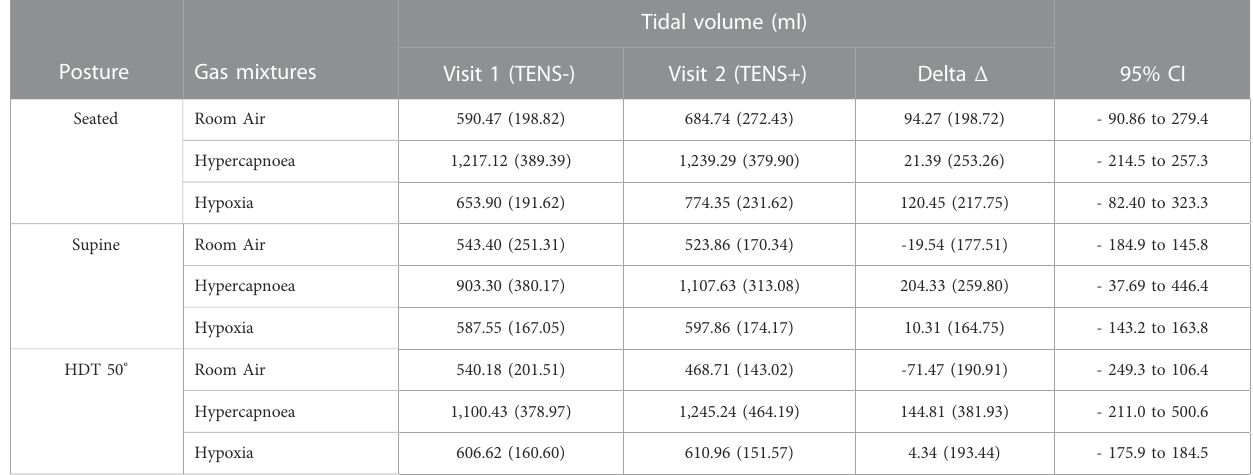
TABLE 7 Tidal volume with and without electrical stimulation in seated, supine and HDT postures. Data are presented as mean (SD). HDT, head down tilt. TENS-, electrical current off. TENS + electrical current turned on. CI, 95% con fi dence interval.